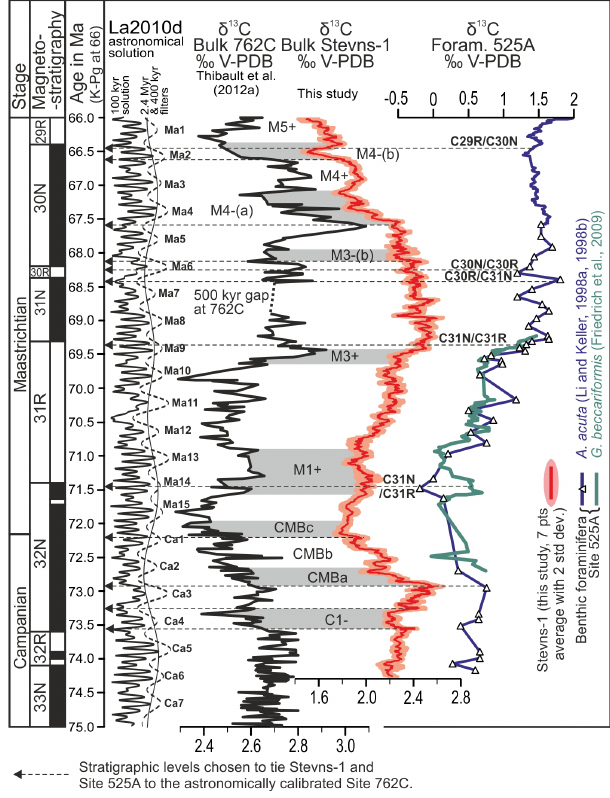
Figure 2. Age model for the Stevns-1 core based on the correla- tion of carbon-isotope curves of Stevns-1 with the astronomically calibrated ODP Site 762C and DSDP Site